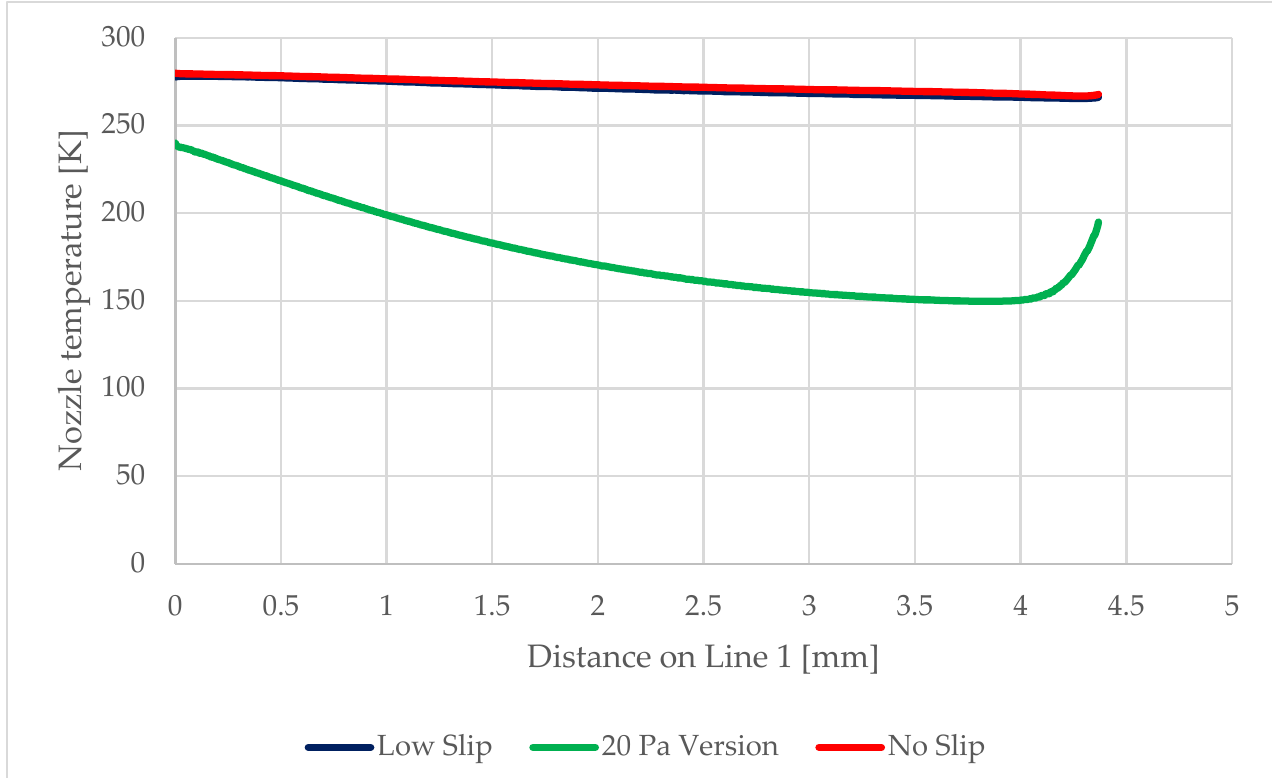
Figure 28. Distribution of reading points in the nozzle.